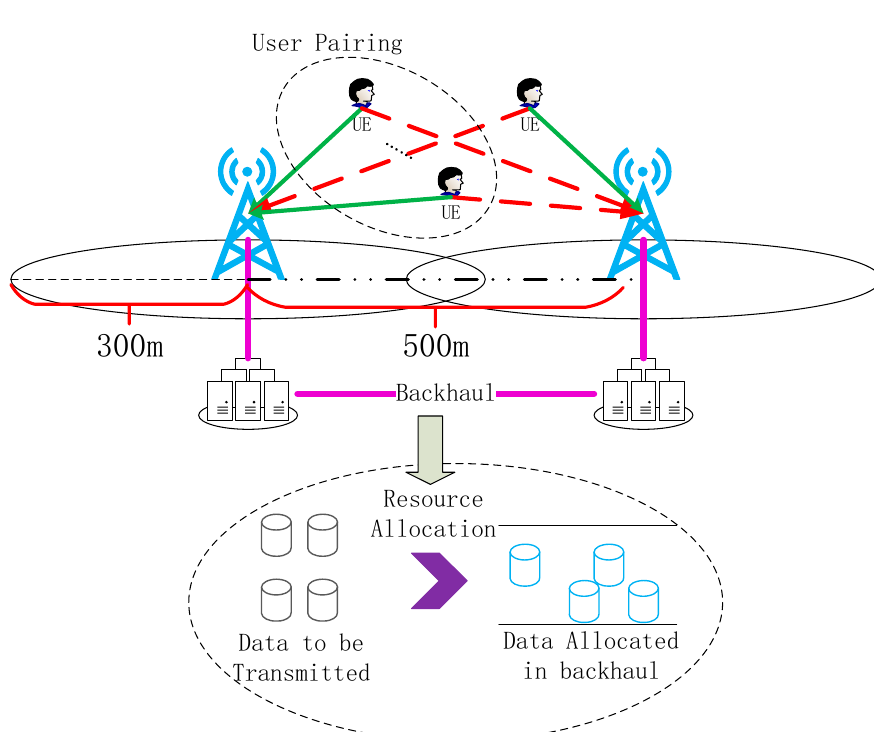
Figure 2. Scenario of the theoretical analysis. Two base stations are connected through the cooperative link and our proposed method is given.